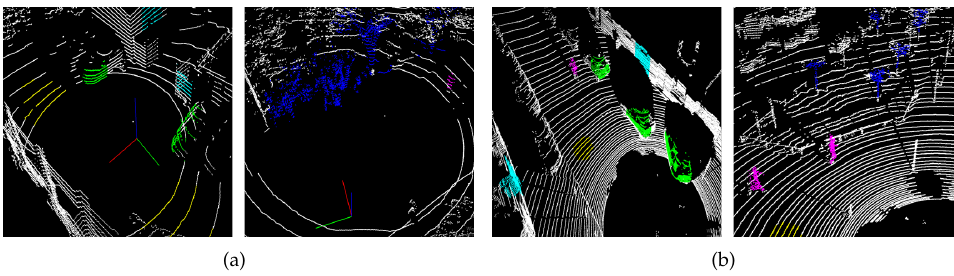
Figure 6. Raw data labeled by points of interest. Purple indicates persons, green cars, blue trees, sky blue buildings, and yellow floors. Samples from ( a ) the KNU dataset using 16-channel LiDAR acquisition and ( b ) the KITTI dataset using 64-channel LiDAR acquisition.